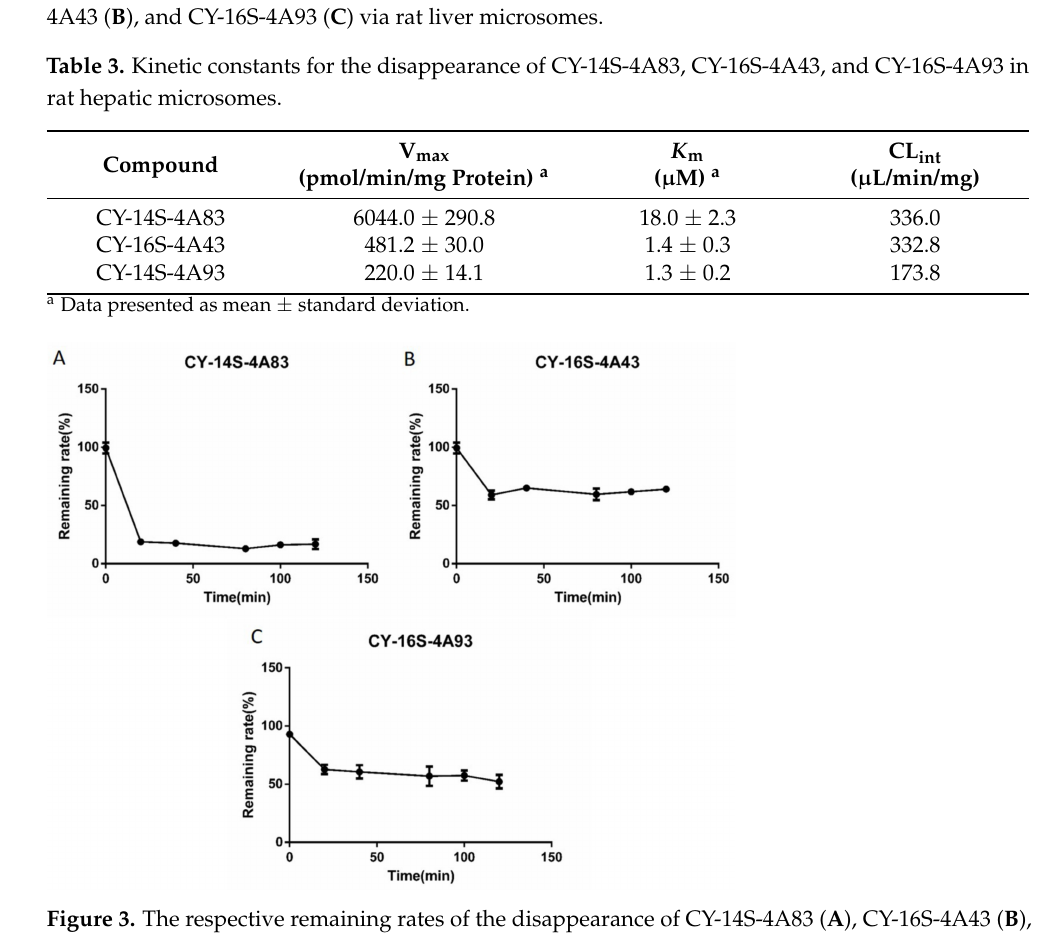
Figure 2. Representative Michaelis–Menten plots of the disappearance of CY-14S-4A83 ( A ), CY-16S-